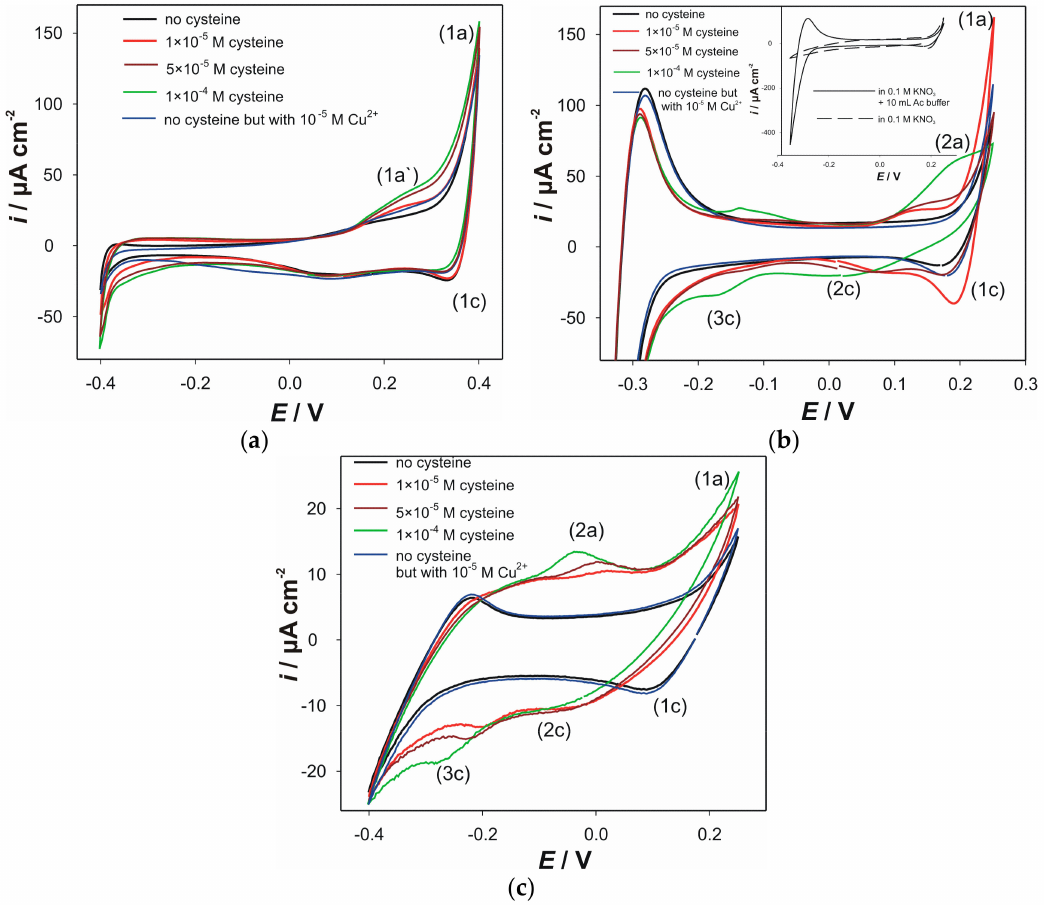
Figure 1. CVs obtained in 90 mL 0.1 KNO 3 + 10 mL 0.1 M acetate buffer (pH 5) without and